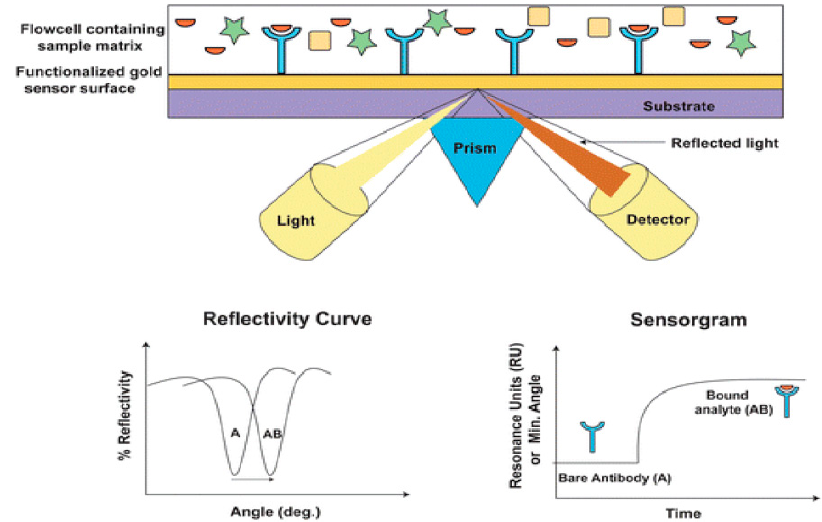
Figure 2. Operating principle of conventional SPR sensor based on Kretschman configuration: the target binding to the immobilized receptor ( up, center ) causes a time-variation of the refractive index of the medium near the surface which is monitored by the shift of the resonance angle ( below, left ) or resonance wavelength ( below, right ) (reproduced from [24] with permission of RSC Publishing).